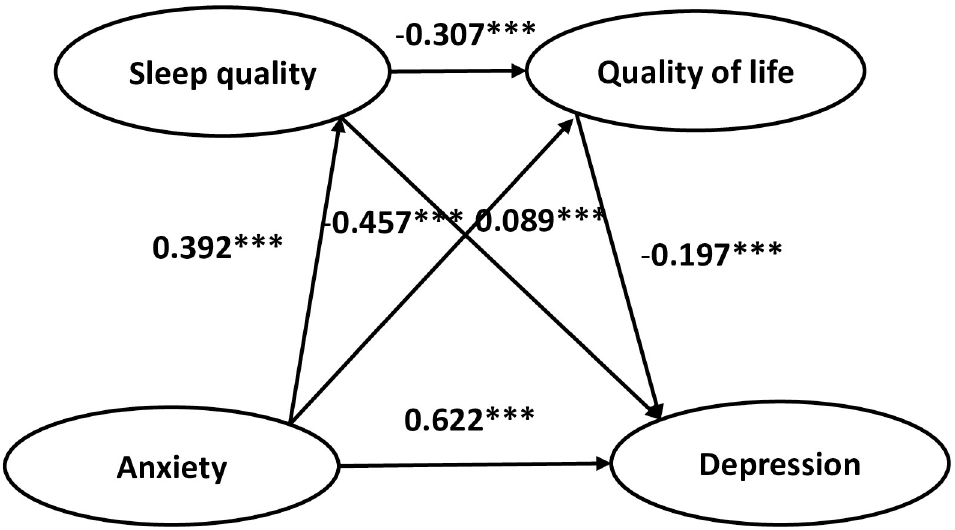
Fig 1. Model of mediating roles of sleep quality and quality of life between anxiety and depression. ��� P < 0.001.